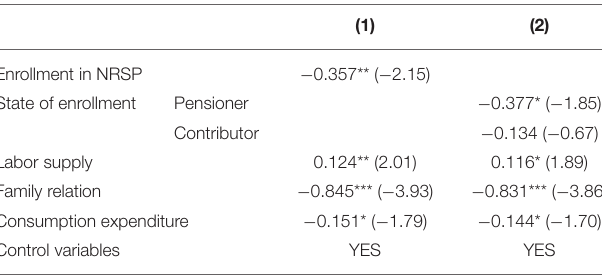
TABLE 9 | Results of the mediating